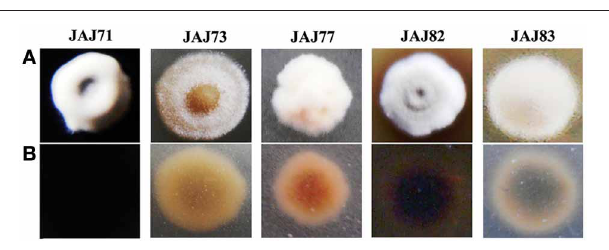
FIGURE 5 | Colony morphology of representative actinomycete isolates derived from inland solar salterns. (A) represents the colony view from aerial mycelium side and (B) is the substrate mycelium view. Colonies were distinguished based on the color of aerial and substrate mycelia and